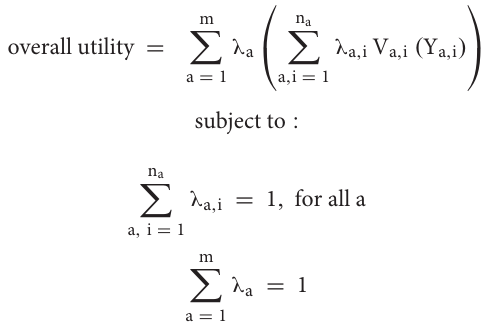
TABLE 4 | Weights for biodiversity and ecosystem service (BES) group indicators ( λ a ) for four alternative weighing scenarios at three case study enterprises (CSEs). CSE